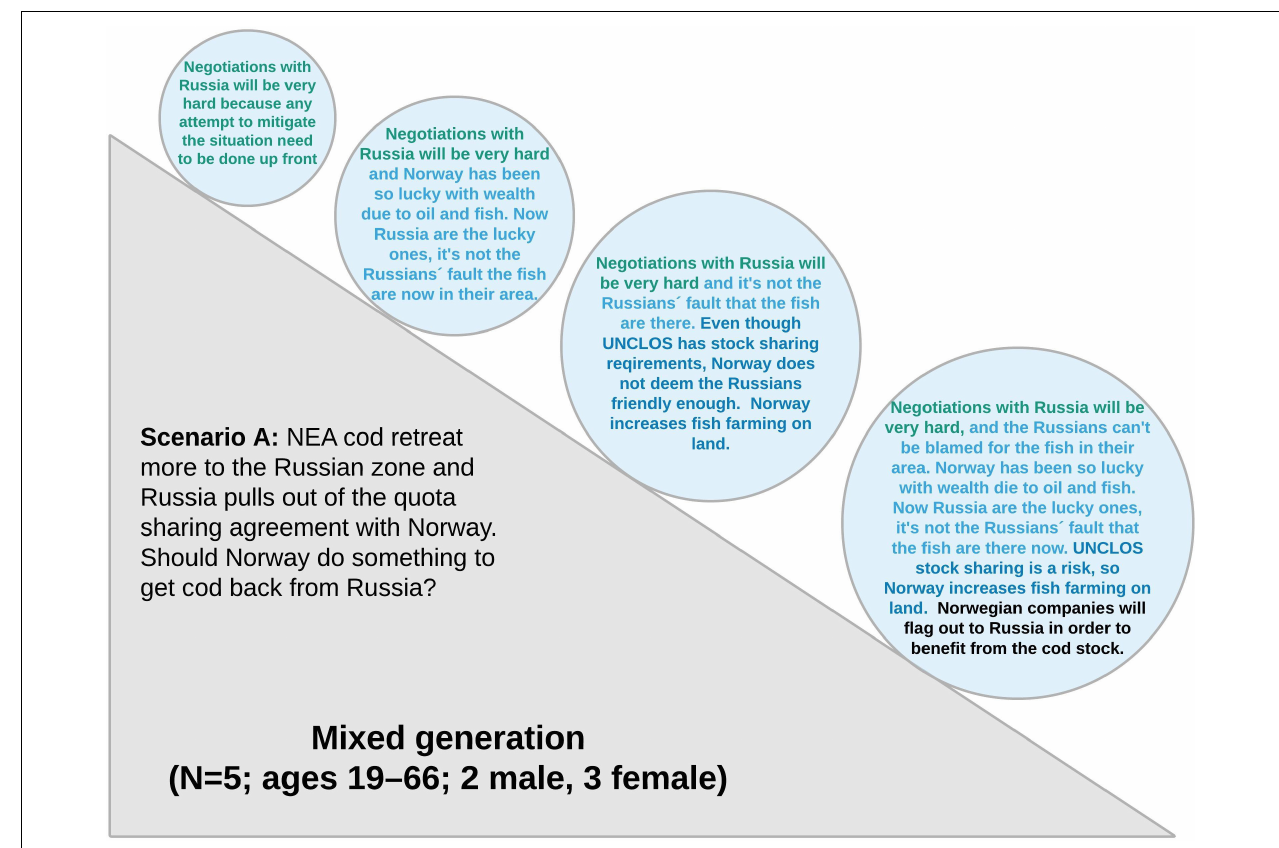
FIGURE 9 | A schematic of the results of a discussion among a mix of ages in Bergen, Norway, June